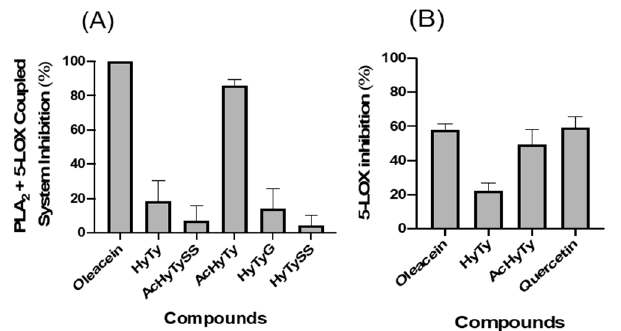
Figure 4. Inhibitory activity of the oleacein, HyTy, AcHyTySS, AcHyTy, HyTyG or HyTySS, at a concentration 100 µM, on the PLA 2 + 5-LOX coupled system ( A ) and on the 5-LOX enzyme ( B ). Results are expressed as the mean ± SEM of four independent assays, each one performed in duplicate. Quercetin was used as the positive control for the 5-LOX assay.